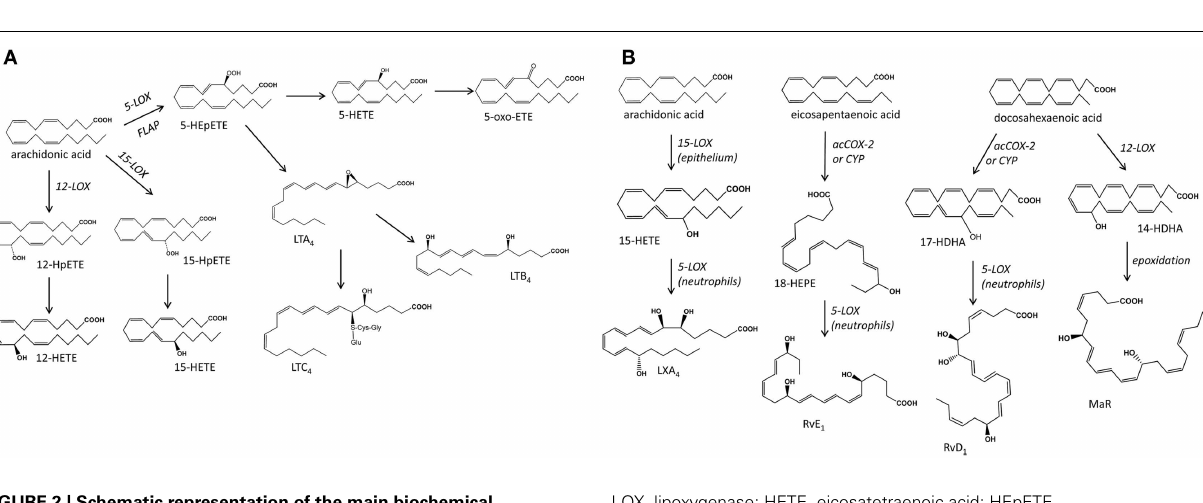
LOX, lipoxygenase; HETE, eicosatetraenoic acid; HEpETE, eicosaperoxytetraenoic acid; LT, leukotriene; acCOX-2, acetylated cyclooxygenase-2; CYP, cytochrome P450; LX, lipoxin; RvE, resolving series E; RvD, resolving series D; MaR,